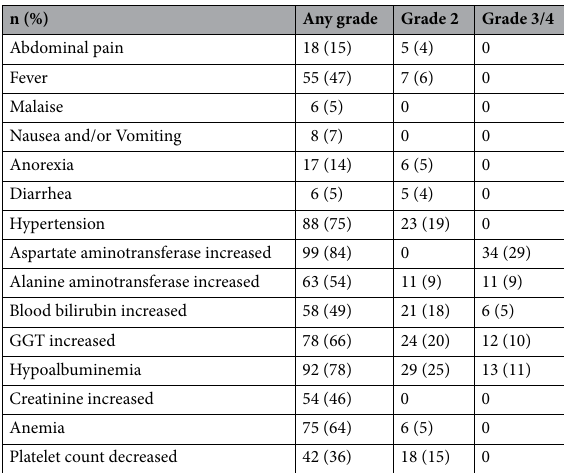
Table 3. Adverse events of UFP therapy. CTCAE